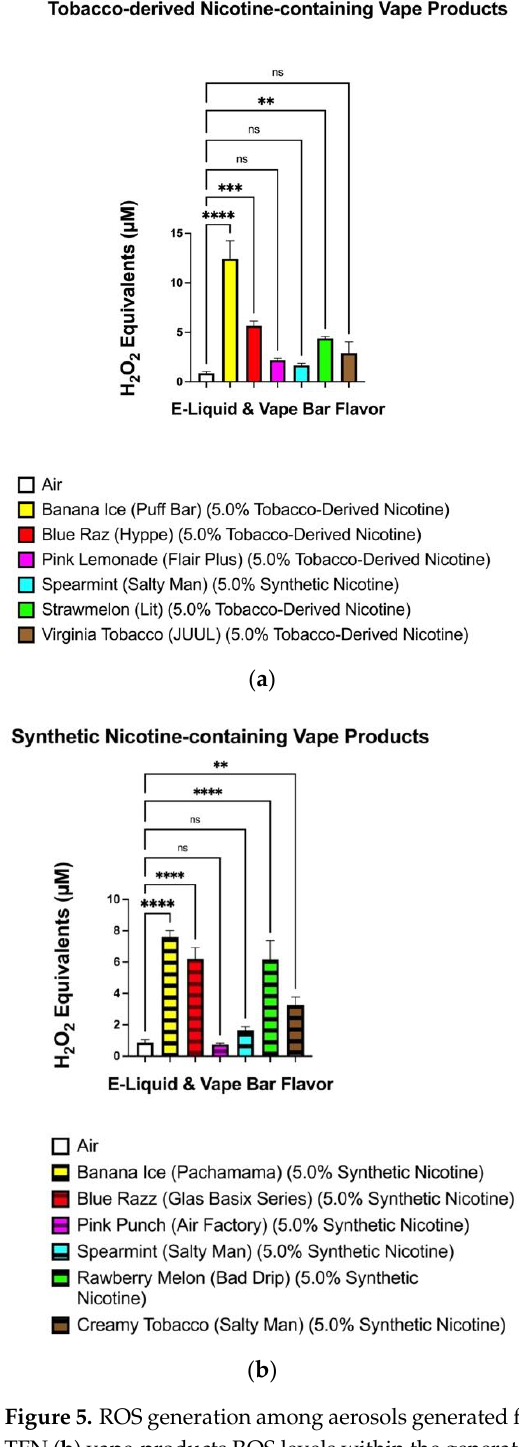
Figure 5. ROS generation among aerosols generated from tobacco-derived nicotine-containing ( a ) and TFN ( b ) vape-products ROS levels within the generated aerosols from each individual flavored TFN e-liquid and tobacco-derived nicotine-containing vape products were measured via spectrofluorometry and quantified as H 2 O 2 equivalents. During analysis, the level of ROS generated from each individual vape-bar and e-liquid was compared to the ROS generated from the filtered air control. Data are represented as mean ± SEM, and significance was determined by one-way ANOVA. ** p < 0.01, *** p < 0.001, and **** p < 0.0001 versus air controls. ns is abbreviated for “Non - Significant” versus air -controls ( p > 0.05). Sample size (N) = 3 – 4.